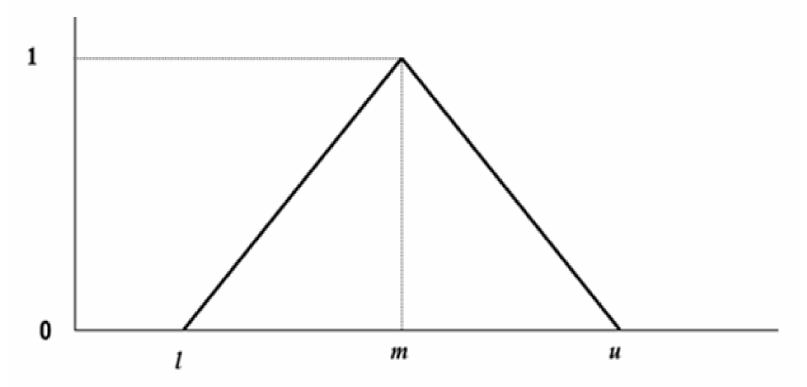
Figure 4. Triangular fuzzy number.